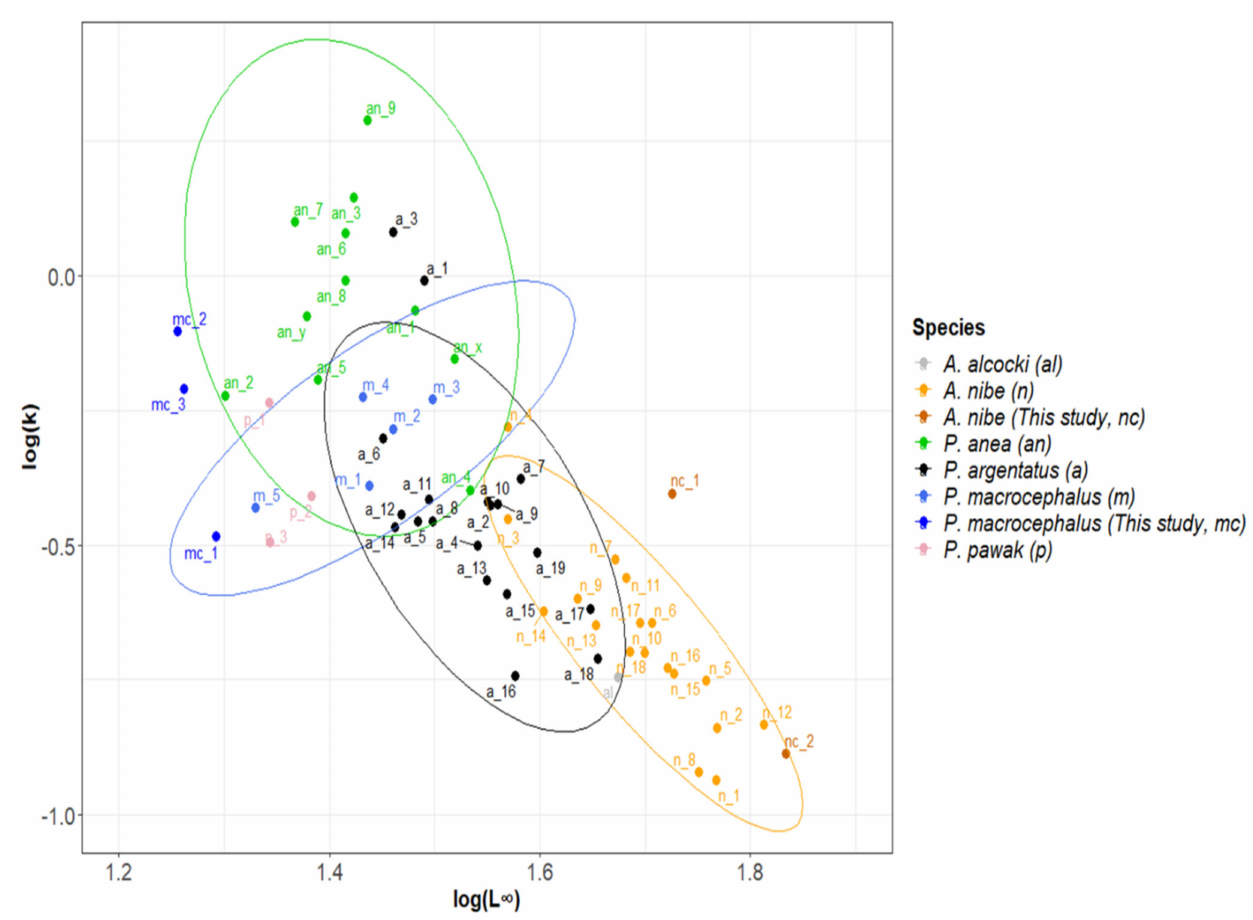
Figure 8. Auximetric plot of the two variables, log( L ∞ ) and log( k ), of the growth performance index formula obtained from the previous studies globally of Sciaenidae family. Ellipses with a 95% confidence interval. Code referred to Table